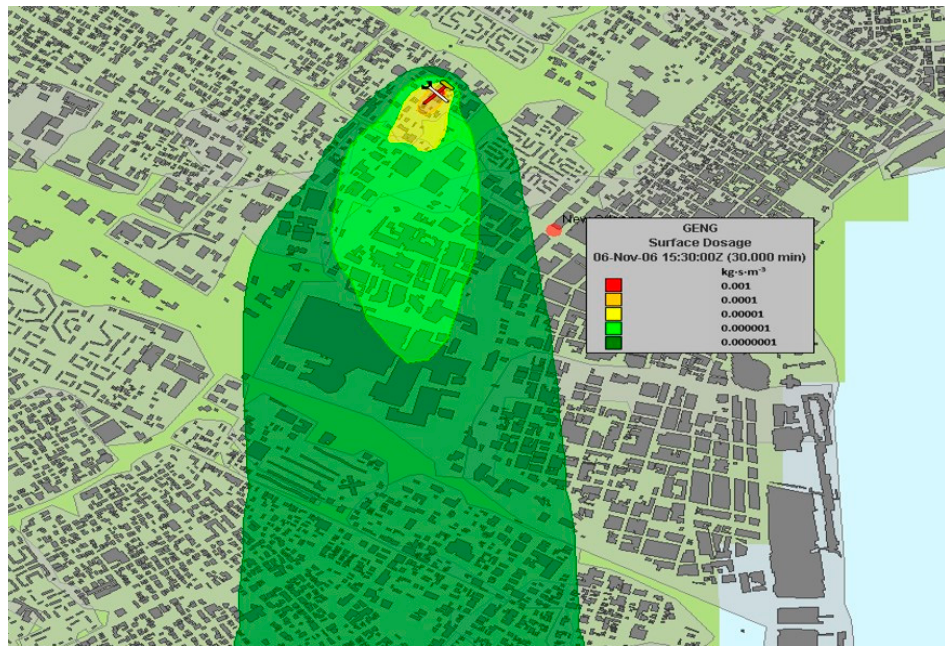
Figure 1. Example of urban dispersion prediction provided by Urban Dispersion Model (UDM). Colour contours show downwind dispersion of plume through the urban environment. From Herring, S. and Huq, P., 2016, 17th International Conference on Harmonisation within Atmospheric Dispersion Modelling for Regulatory Purposes [7].